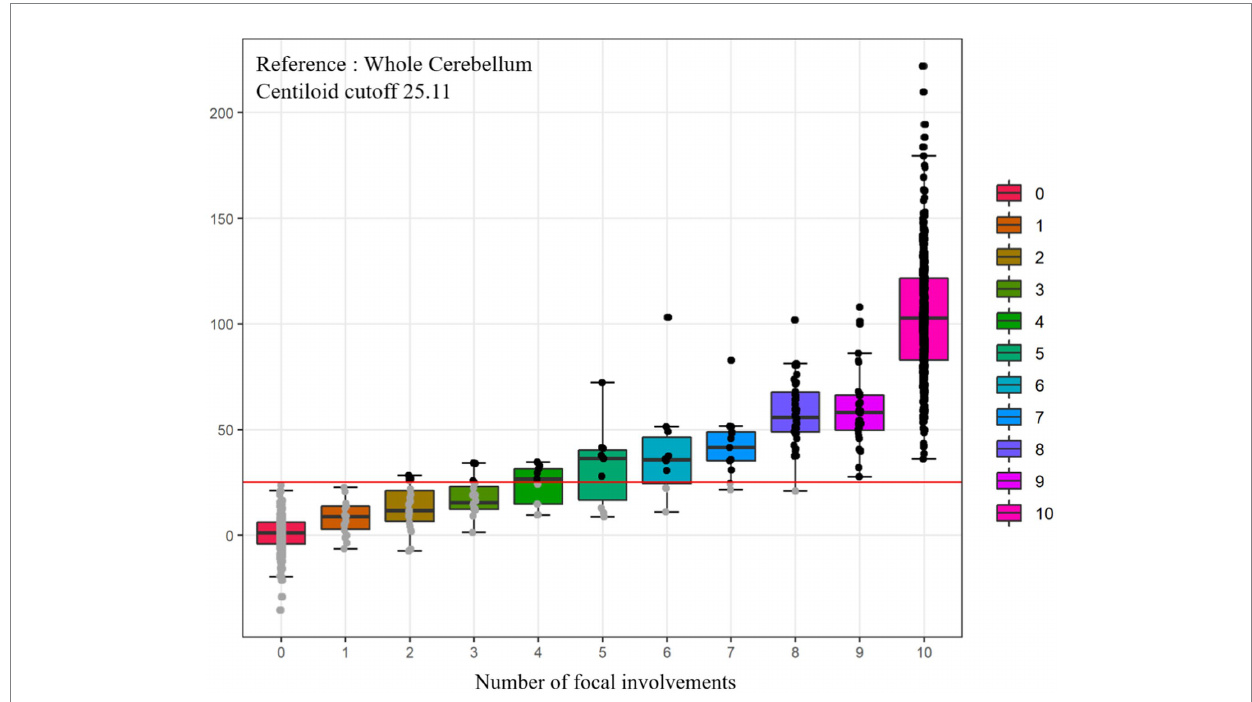
FIGURE 2 Comparisons of Centiloid values according to numbers of focal amyloid PET involvement. Total n = 968, FBB ( n = 498, ref. WC), FMM ( n = 470, ref. WC). PET, positron emission tomography; WC, whole